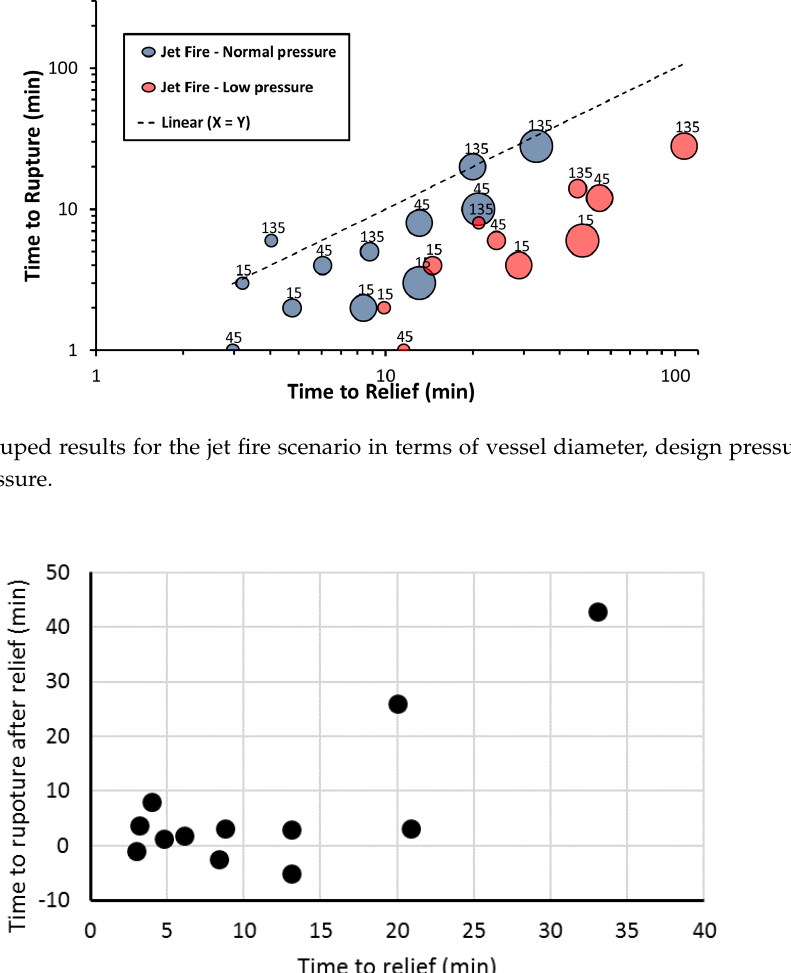
Figure 8. Extension of vessel rupture time after the onset of relief as a function of time to relief for pool fire cases with normal operating pressure. Negative values indicate that rupture is predicted to occur before PRV relief pressure is reached.